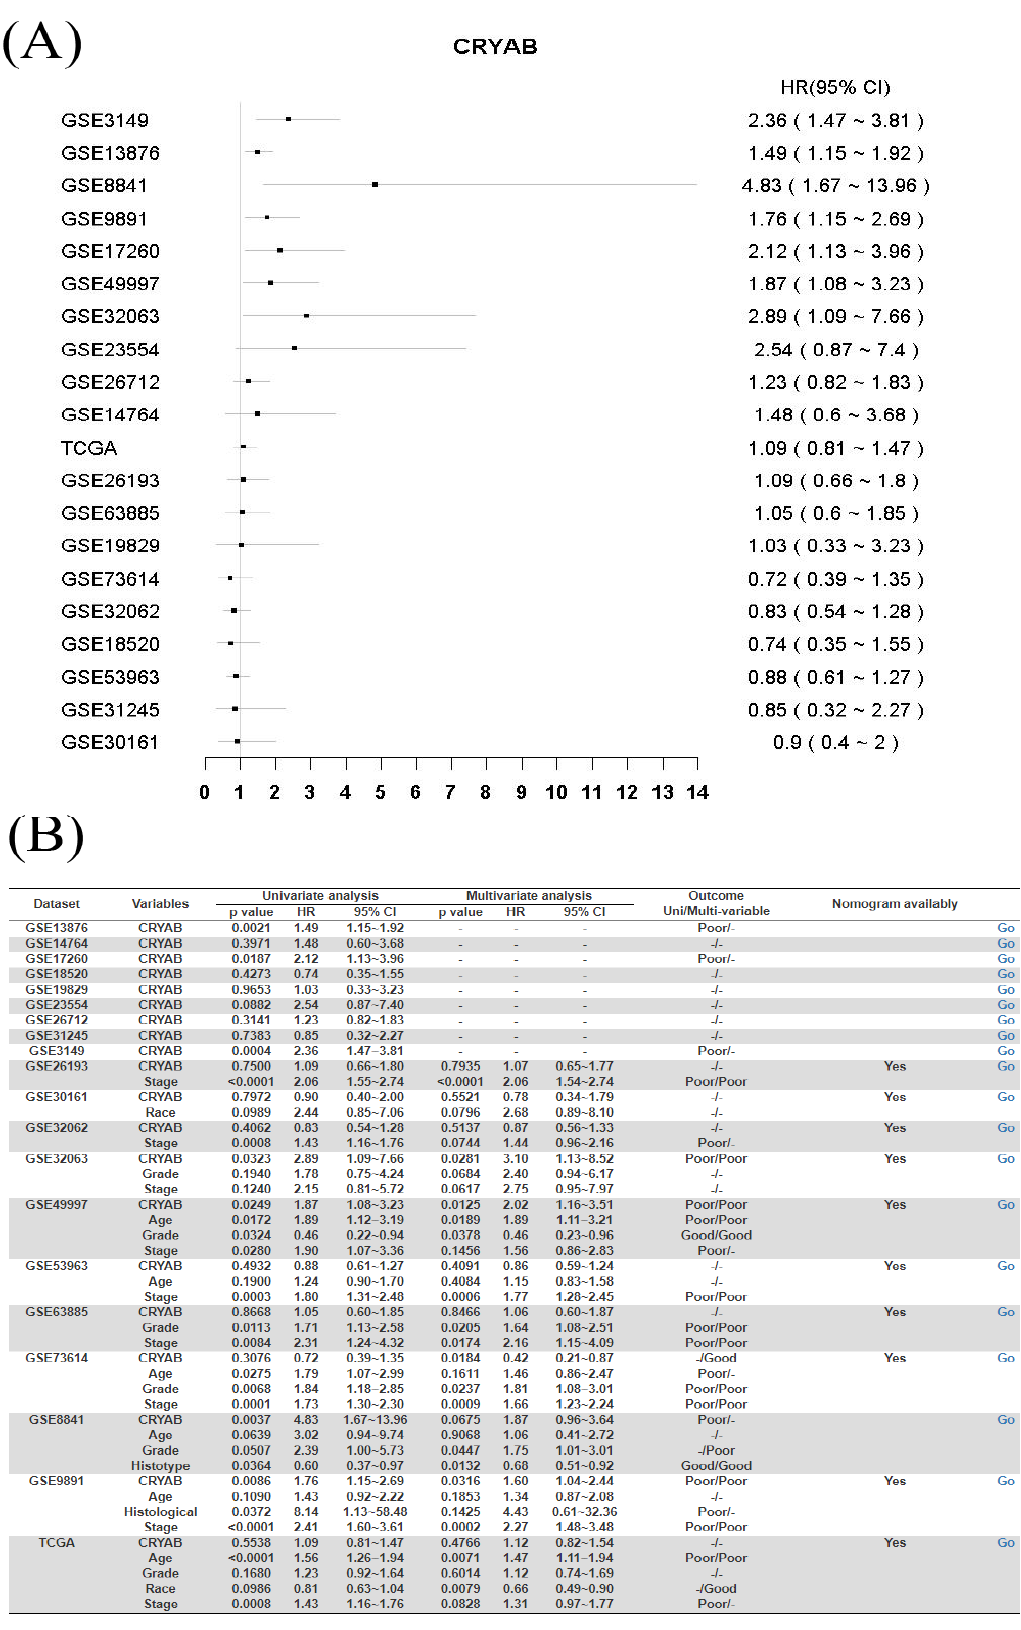
Figure 2. The output homepage for CRYAB gene survival analysis in ovarian cancer using OSov. ( A ) the forest analysis for CRYAB gene; ( B ) a survival analysis summary table in independent cohorts for CRYAB gene. CRYAB: crystallin alpha B. Cutoff value is the upper 25% vs. other 75%.